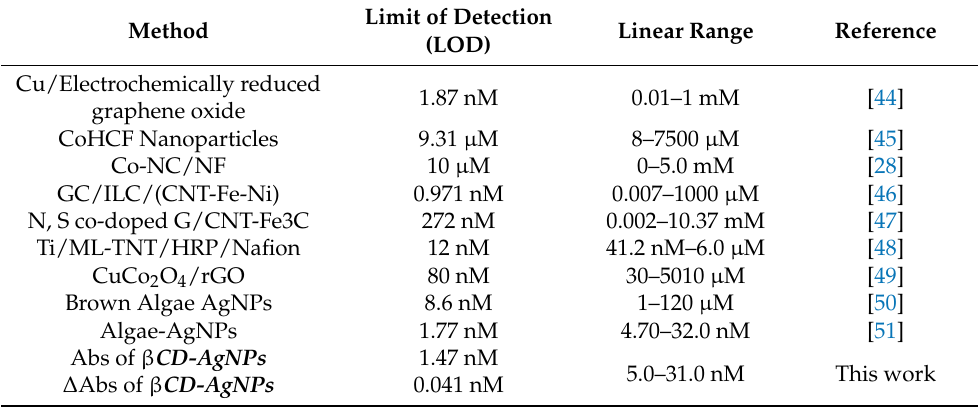
Table 1. Analytical performance of the β CD-AgNPs during H 2 O 2 detection in comparison with other H 2 O 2 non-enzymatic tests.